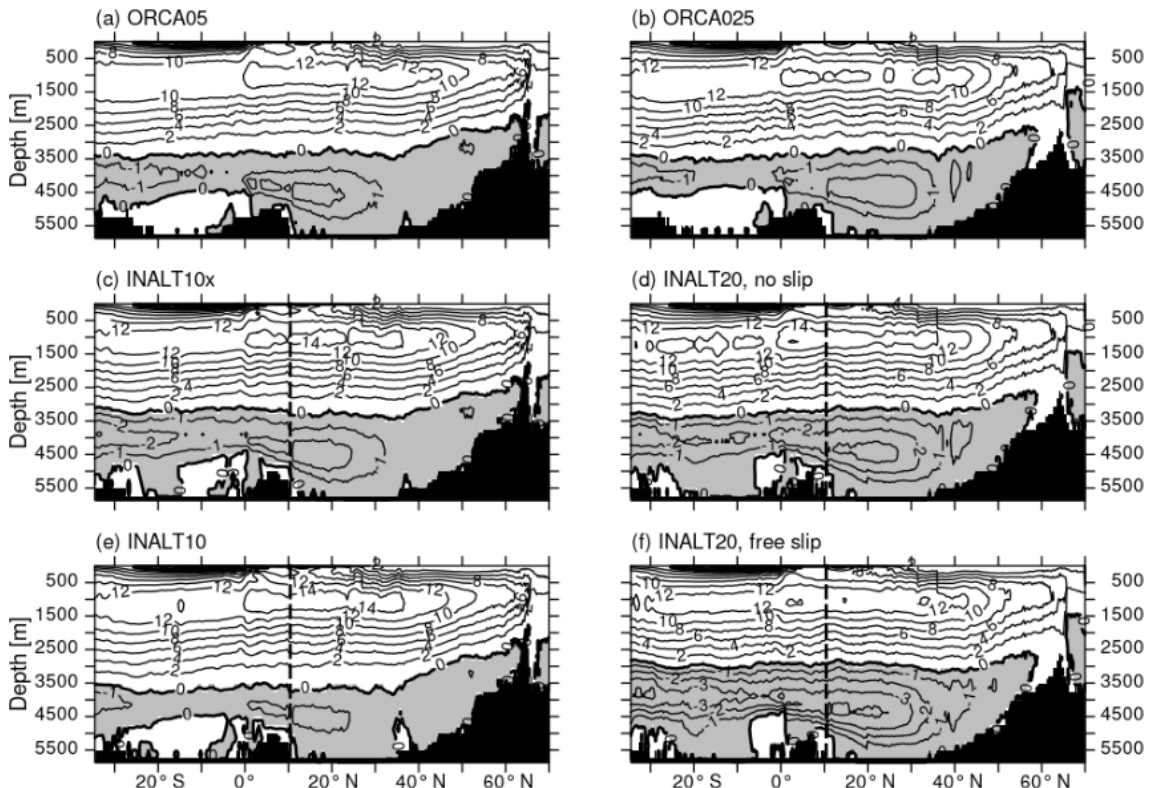
Figure 11. Mean AMOC (in Sv) for the period 2005–2009 from the hindcast experiments within the different configurations: (a) ORCA05, (b) ORCA025, (c) INALT10x, INALT20 with no-slip (d) and free-slip (f) lateral boundary condition and (e) INALT10. The dashed lines in panels (c) to (f) indicate the northern boundary of the nested regions. Contour intervals are 1Sv for negative (grey shaded) and 2Sv for positive (white) transport.